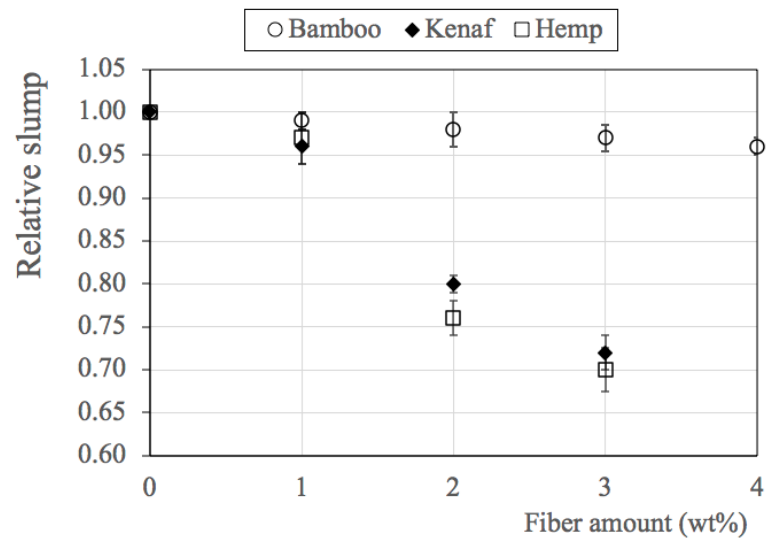
Figure 3. Relative workability of the investigated composites.